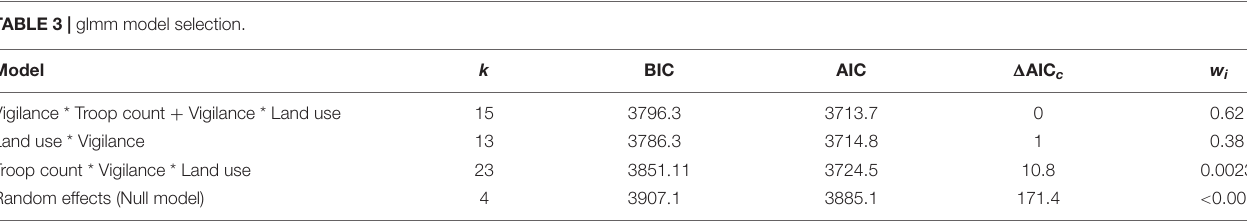
TABLE 3 | glmm model